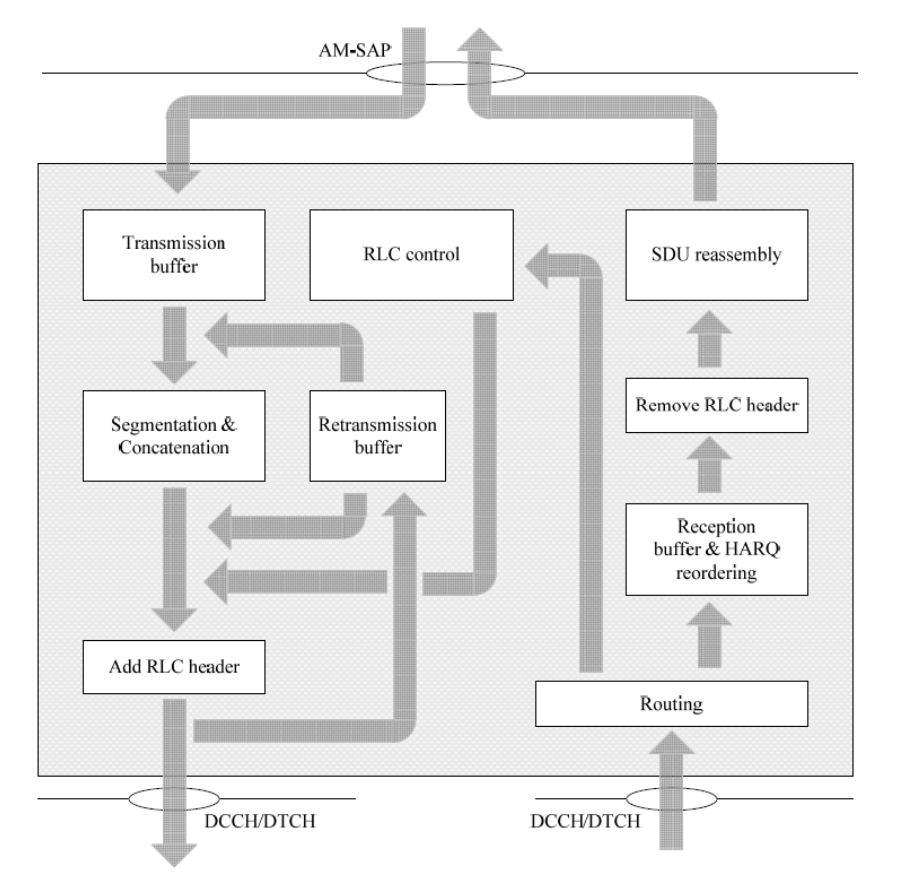
Figure 2. AM RLC entity. Reprinted with permission from ref. [20]. Copyright 2017